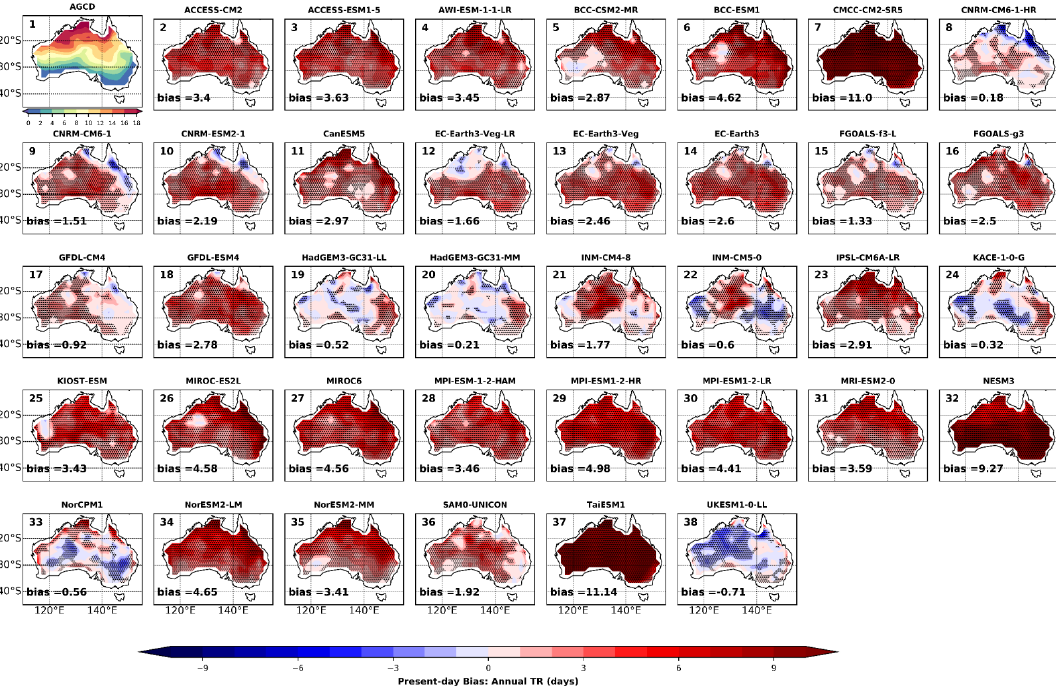
Figure 10. Climatological mean annual bias in tropical nights (number of days when minimum temperature > 20 °C (TR: days) relative to Australian Gridded Climate Data dataset (AGCD; panel 1 ), for the individual CMIP6 GCMs (panels 2 – 38 ). Data spans 1951–2014. Stippling indicates statistically significant differences using a student’s t -test at the 95% confidence level.